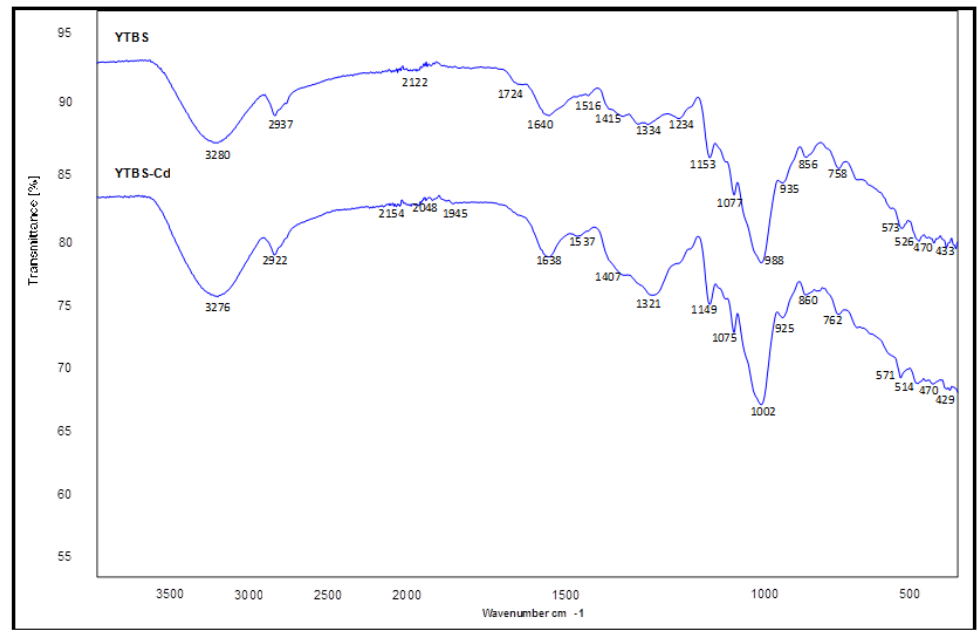
Figure 8. Fourier Transform Infrared (FTIR) spectra of YTBS before (YTBS) and after Cd(II) adsorption